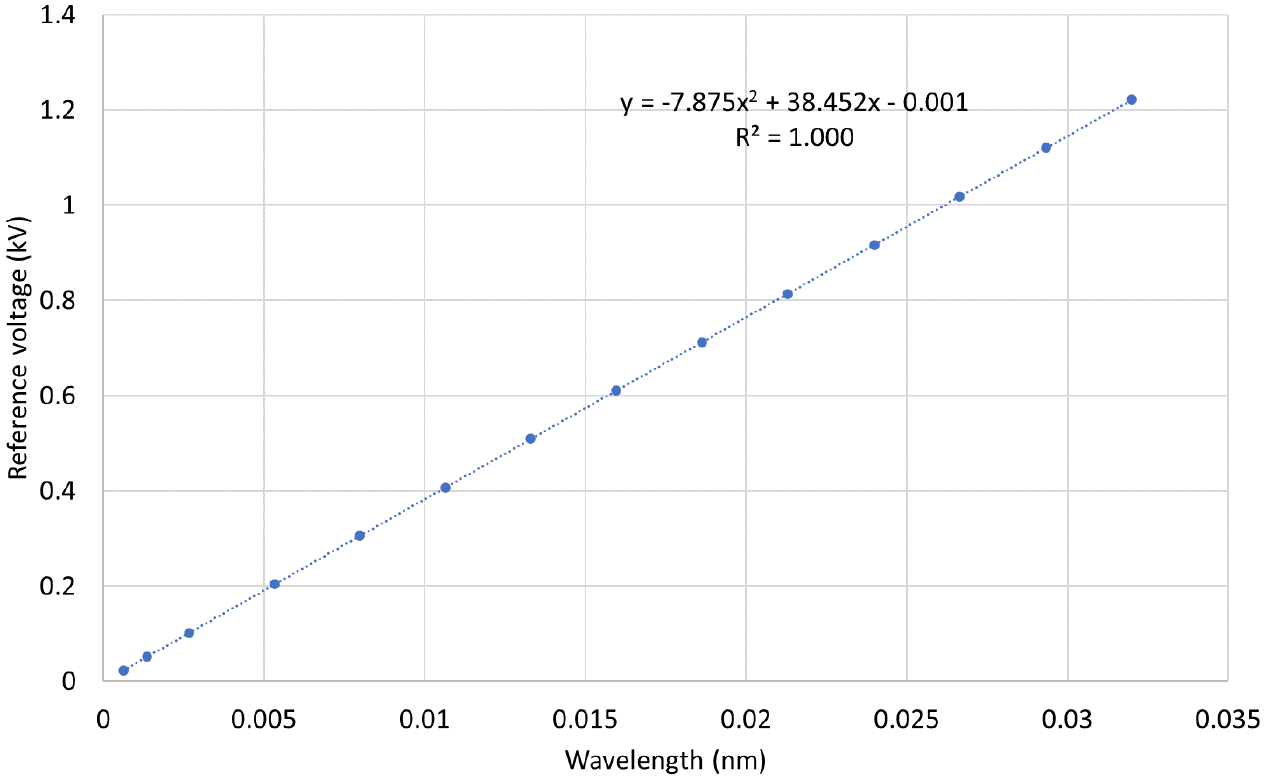
Figure 7. MVT calibration curve.